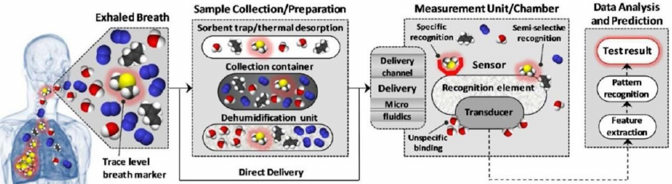
Figure 1. Schematic of various steps followed for analysis of exhaled breath. Reprinted with permission from Ref. [9] Copyright 2014 American Chemical